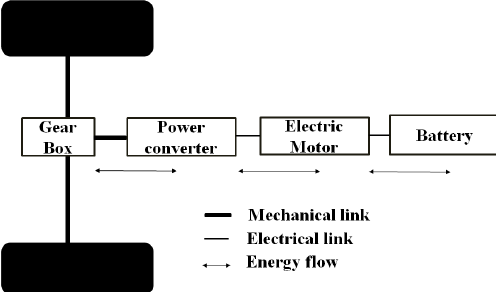
Figure 1. Schematic representation of energy flow in regenerative braking systems.